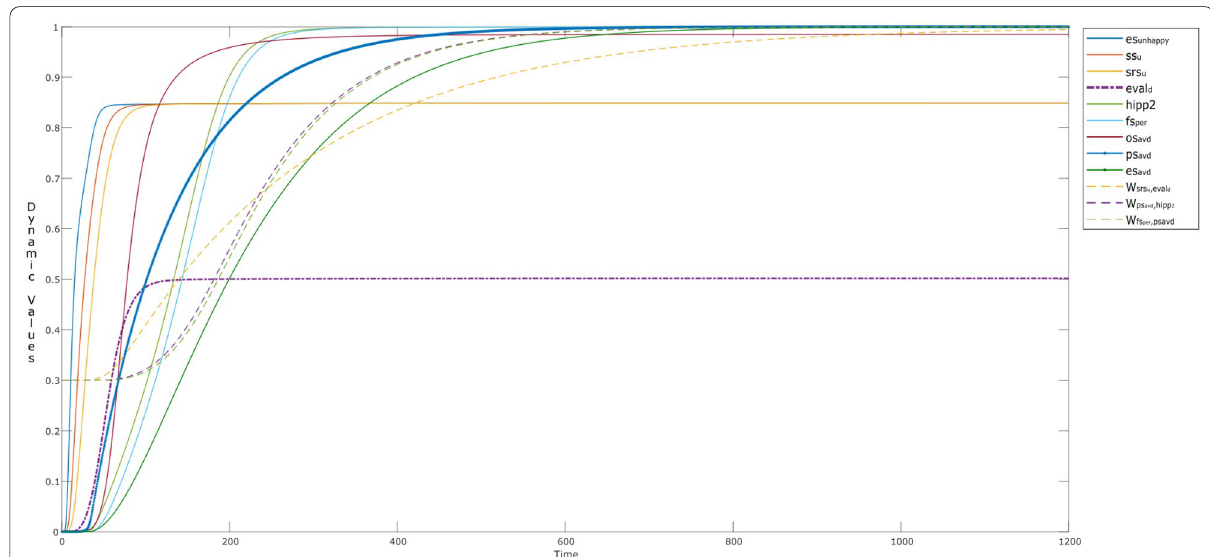
Fig. 12 Child trying to cope with a firm behavior, showing no further